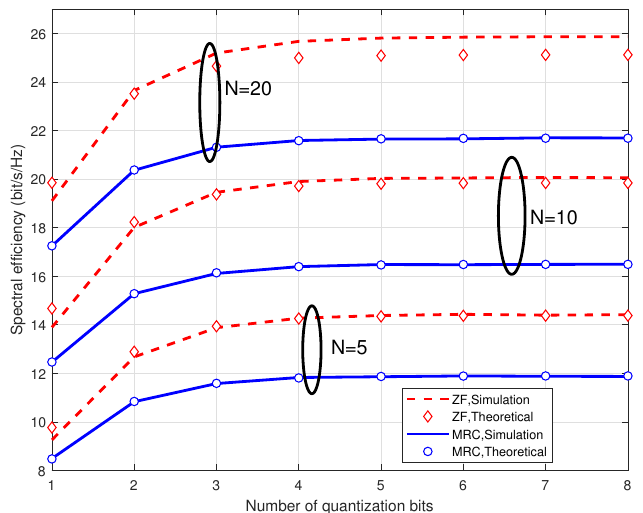
Figure 2. Spectral efficiency versus the number of quantization bits with different numbers of antennas per